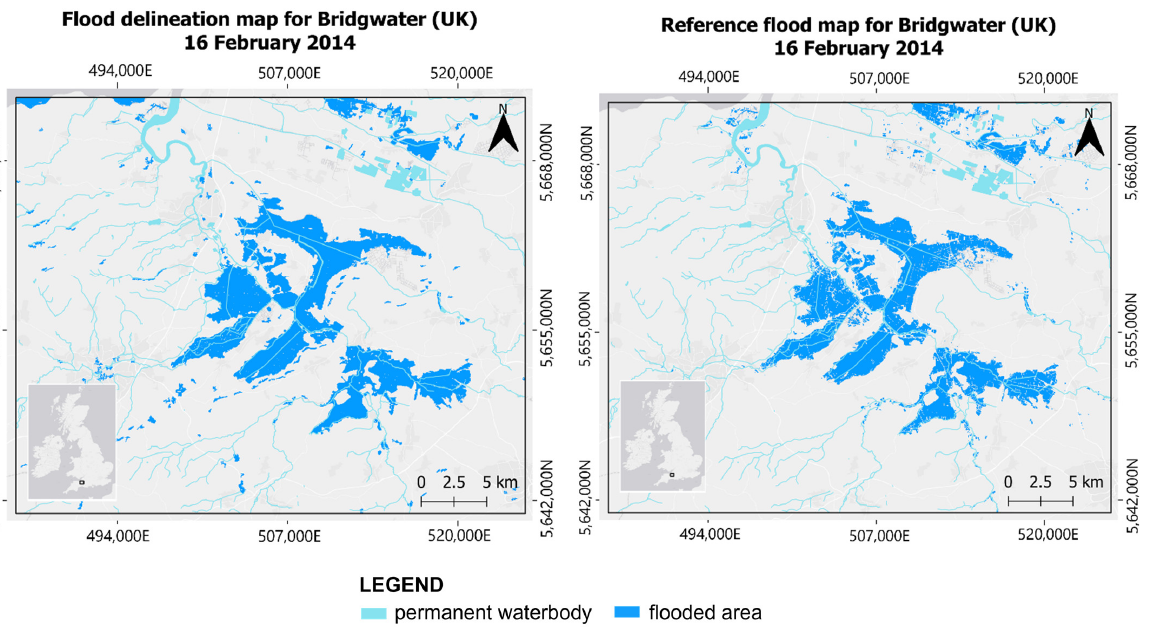
Figure 8. Final flood delineation map ( left panel ) and reference flood map ( right panel ) for the Bridgwater area (UK). CRS: WGS84/UTM zone 30 N. Basemap data: Esri Gray (light) © Esri.